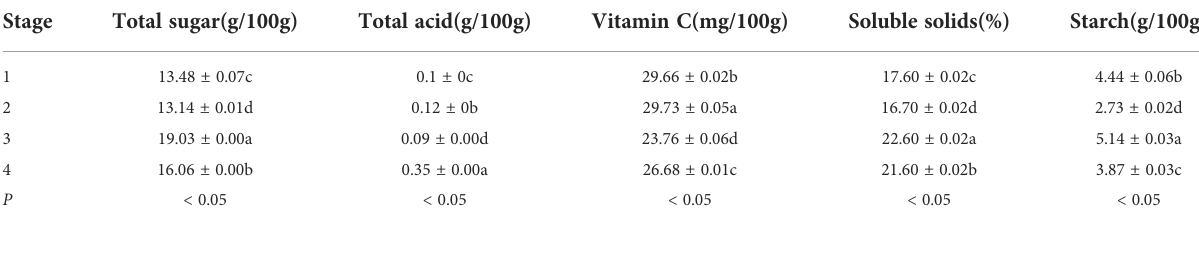
TABLE 9 The content of main nutrients in the pulp at different developmental stages of fruit. Stage